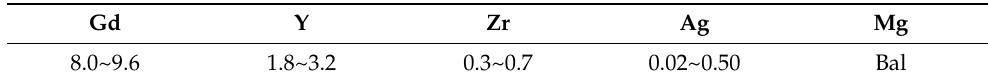
Table 1. Components of the alloy